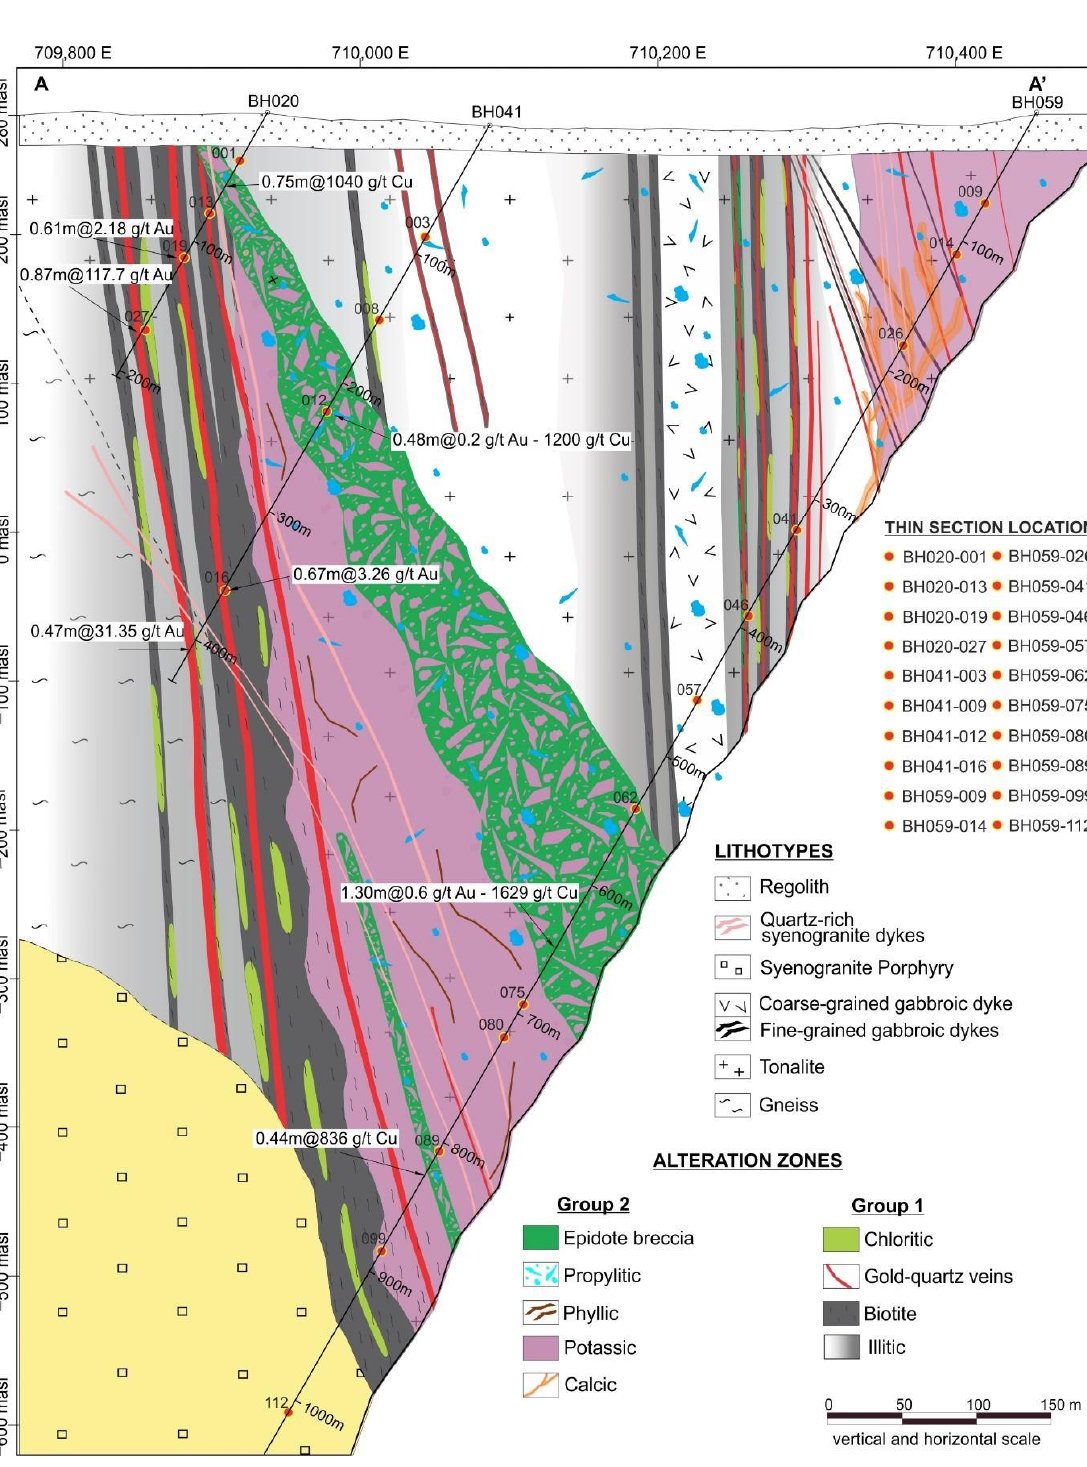
Figure 4. Paraíba main section with hydrothermal alteration zones. Au-Cu geochemical values and width of some main intercepts and thin-section locations in the drill hole are shown. For drill hole locations, see Figure 2. Vertical and horizontal scales are analogous.